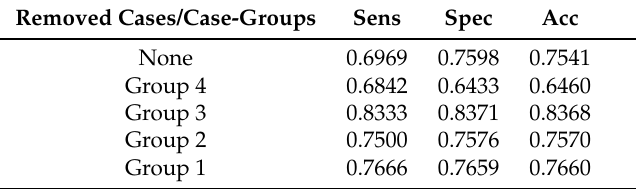
Table 7. Sens, Spec and Acc measures under local influence diagnostics for the asthma